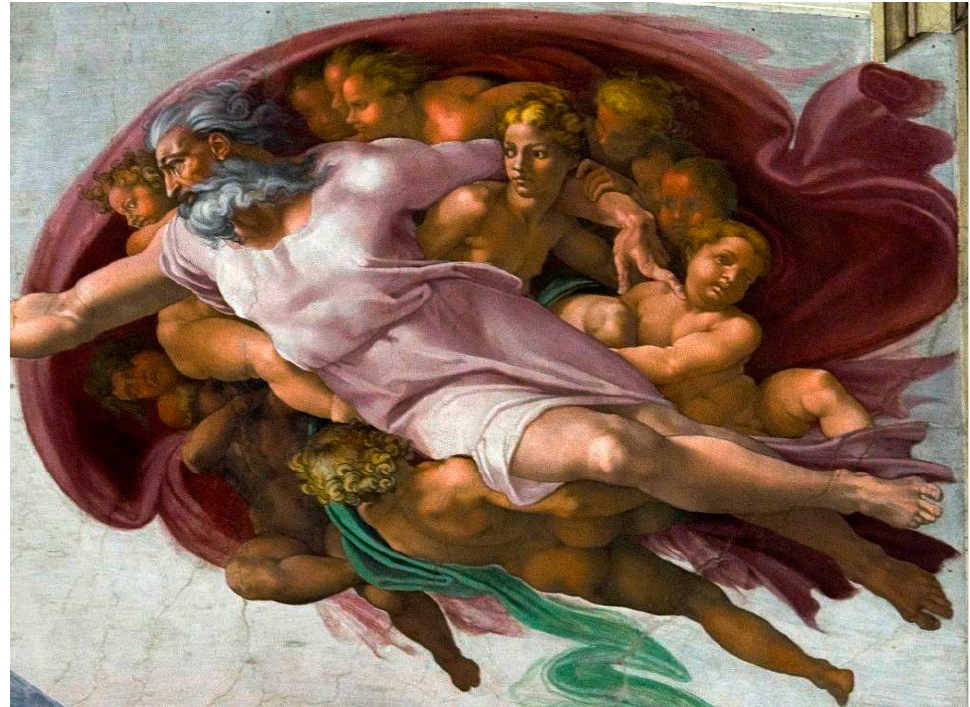
Figure 6. The physical brain of God after Michelangelo in the Sistine Chapel. A close-up view of a section.